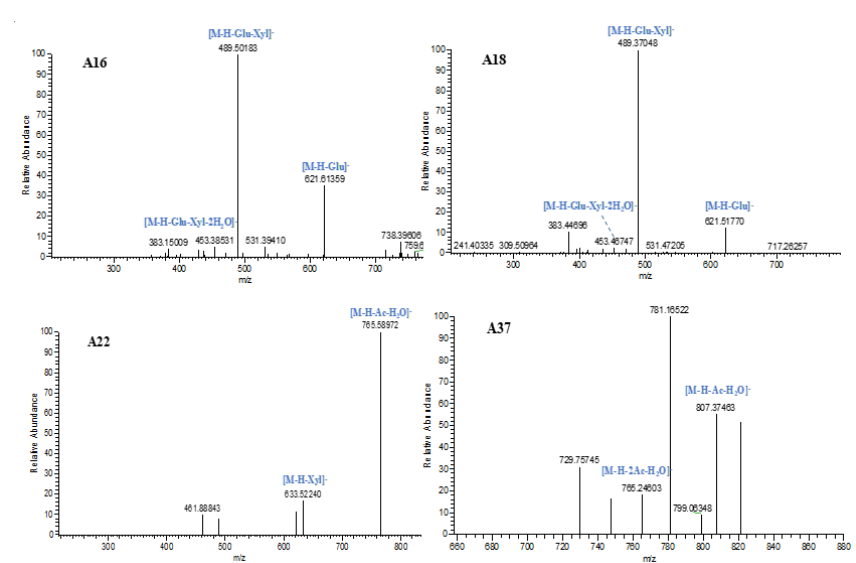
n spectra of A16 , A18 , A22 , and A37 Figure 3. The ESI-MS n spectra of A16, A18, A22, and A37. Figure 3. The ESI-MS